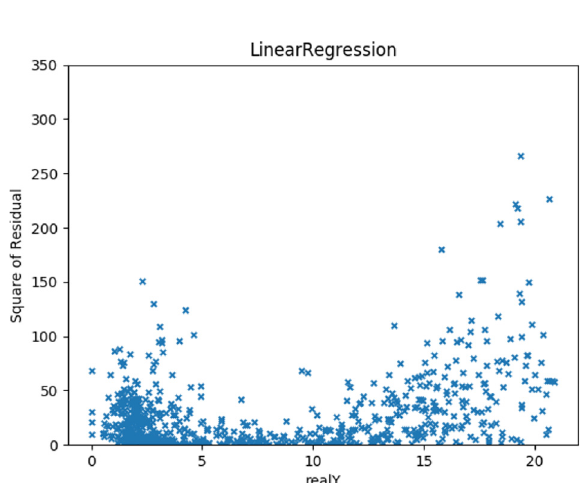
Figure 4. Residual graph of linear regression